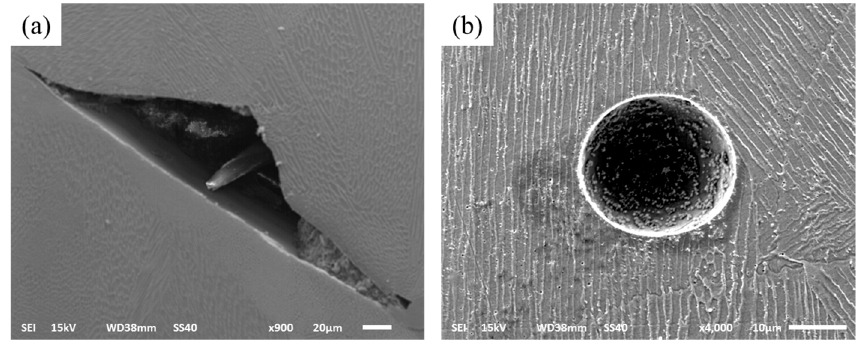
Figure 7. Scanning electron microscope (SEM) micrographs show the different defects ( a ) un-melted defect; ( b ) micropore.